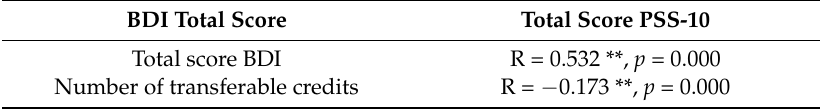
Table 6. The results for the correlational analysis between PSS-10 and BDI total